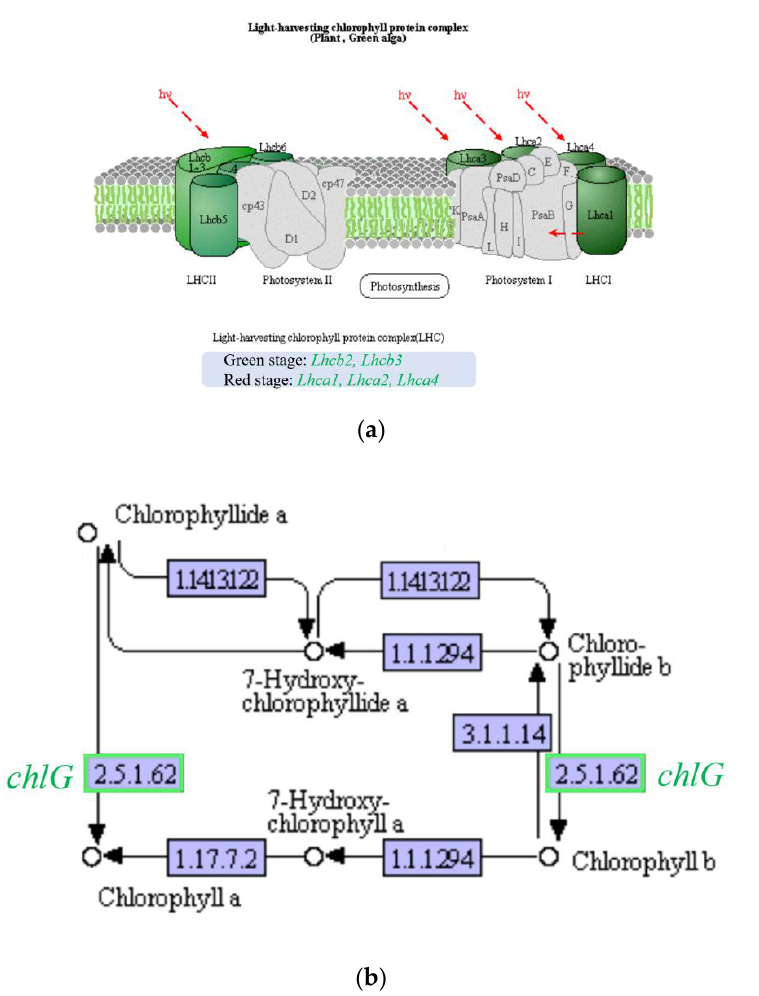
Figure 11. Differentially expressed genes related to photosynthesis: ( a ) Genes related to light harvesting complex; ( b ) Genes related to chlorophyll synthesis.